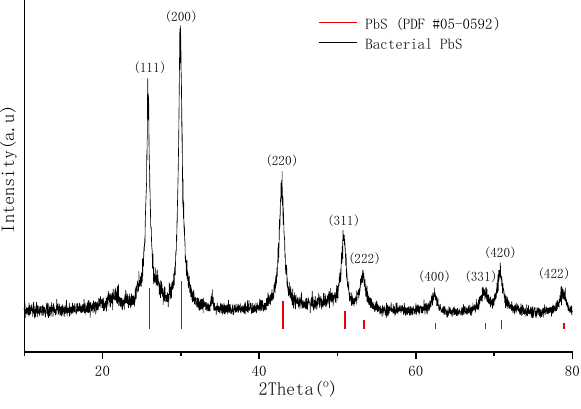
Figure 1. XRD diffraction pattern of bacterial PbS formed by L. sphaericus